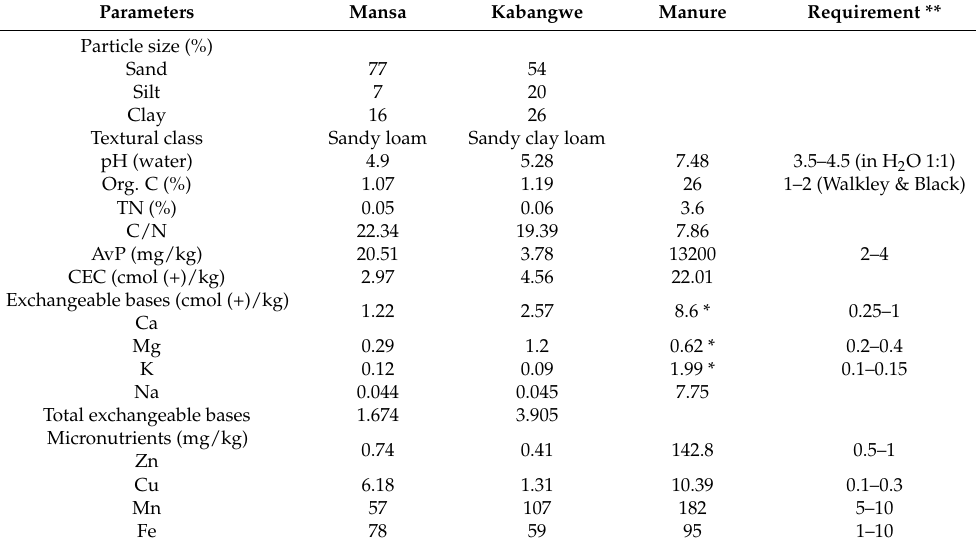
Table 2. Selected physicochemical properties of topsoil (0–20 cm depth) of the two experimental sites and